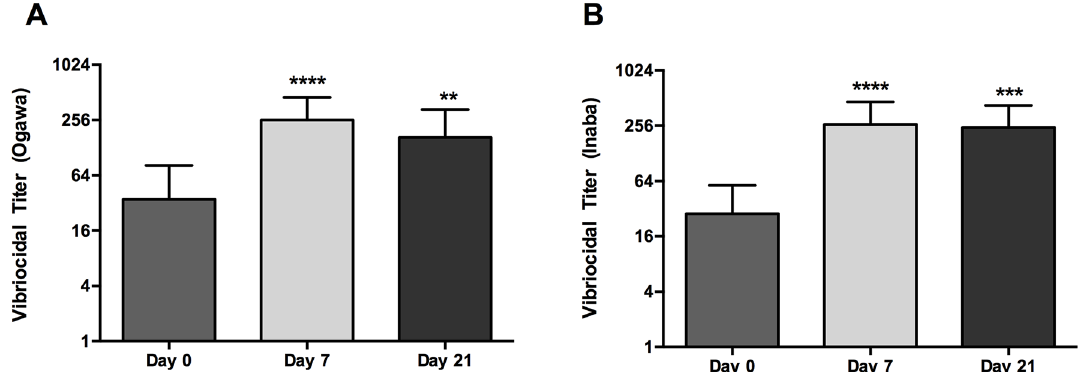
Fig 1. Vibriocidal Responses. Geometric mean titer (+95% CI) of vibriocidal response to V . cholerae O1 Ogawa (A) and Inaba (B) at baseline (day 0) and 7 days after each immunization (day 7 and 21). Statistically significant differences relative to baseline are indicated ( ** = P < 0.01, *** = P < 0.001, **** = P < 0.0001).